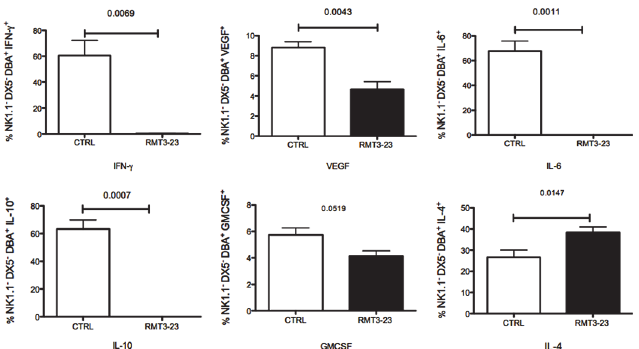
Fig 5. Effect of RMT3-23 treatment on cytokine production by uNK cells. Treatment with RMT3-23 significantly down regulated cytokine production by NK1.1 - DX5 - DBA + cell population. A significant decrease in the population of IFN, IL-6, IL-10, VEGF and GMCSF producing NK1.1 - DX5 - DBA + cells was observed after treatment with RMT3-23 in comparison to Control group, whereas IL-4 production was significantly increased. Data are presented as mean ± SEM and are representative of at least 3 experiments. Statistical analysis was done using unpaired t